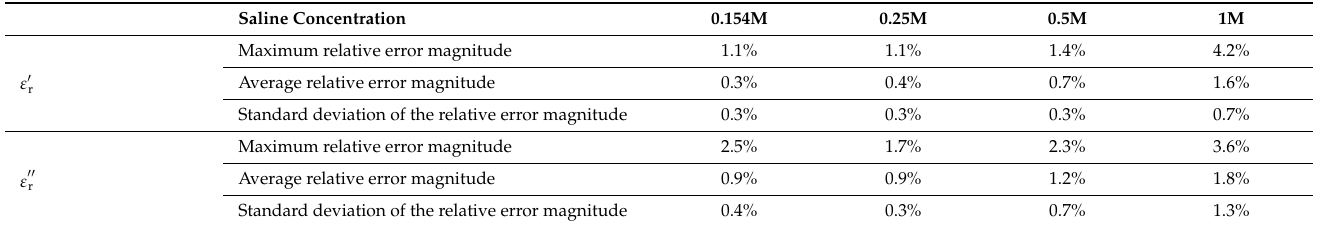
Table 3. CST simulation study—relative errors.